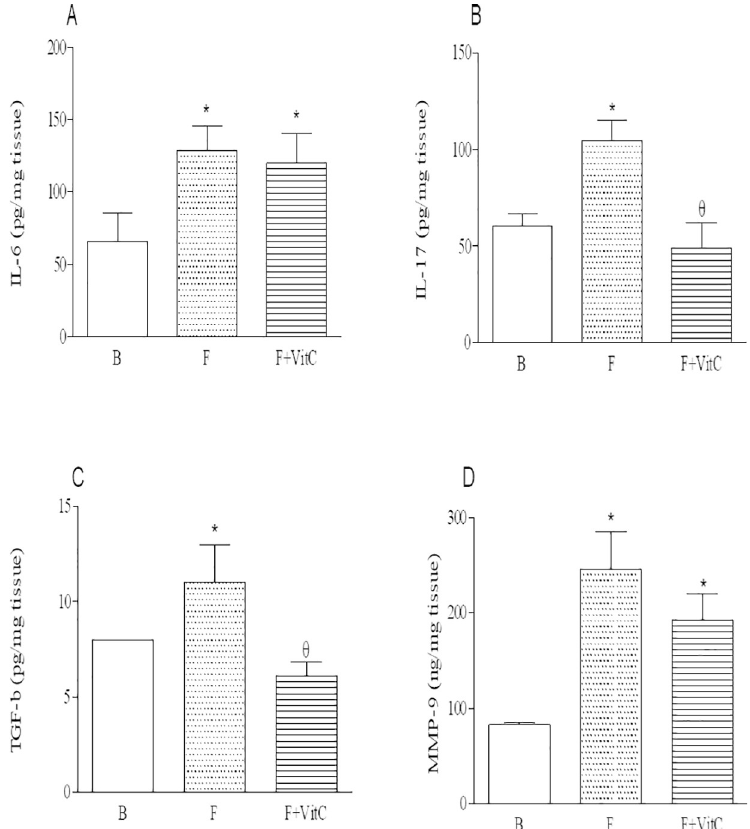
Fig 2. Vitamin C treatment reduces the levels of IL-6, IL-17 and TGF- β in the lung homogenates of PQ-induced fibrosis. Groups of mice were submitted to PQ or vehicle injection and after 7 days the animals were treated with vitamin C or vehicle daily until day 14th. Twenty-four hours after the last treatment the level of cytokines was quantified in the lung homogenates. Data represent the mean ± SEM of 6 animals. � P < 0.05 in relation to B group; θ P < 0.05 in relation to F